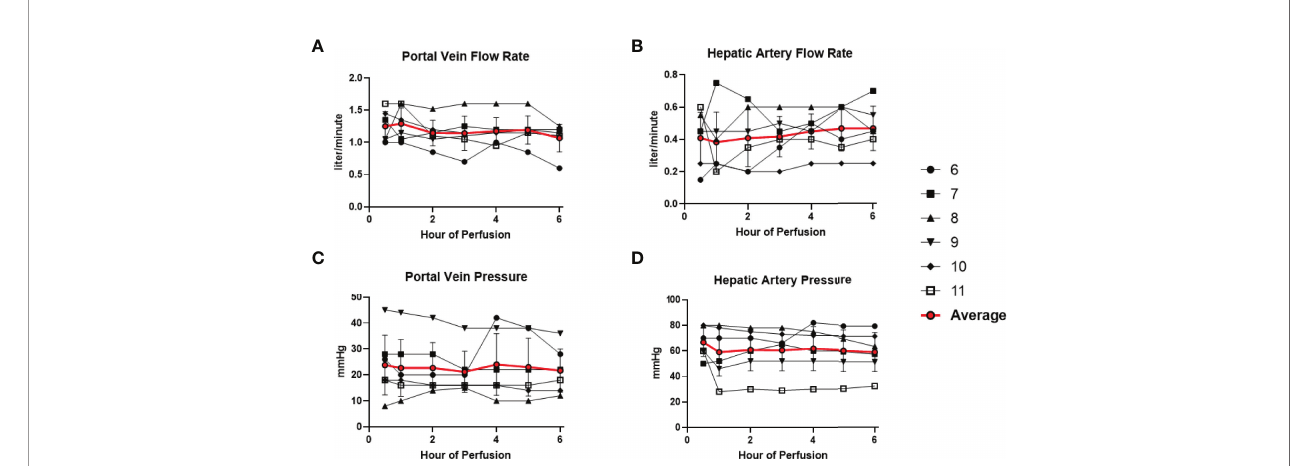
FIGURE 2 | Normal physiologic parameters in all 6 livers were maintained during normothermic machine perfusion. (A) Portal vein fl ow rate (liter/minute) remained stable. (B) Hepatic artery fl ow rate (liter/minute) remained stable. (C) Portal vein pressure (mmHg) remained stable. (D) Hepatic artery pressure (mmHg) remained